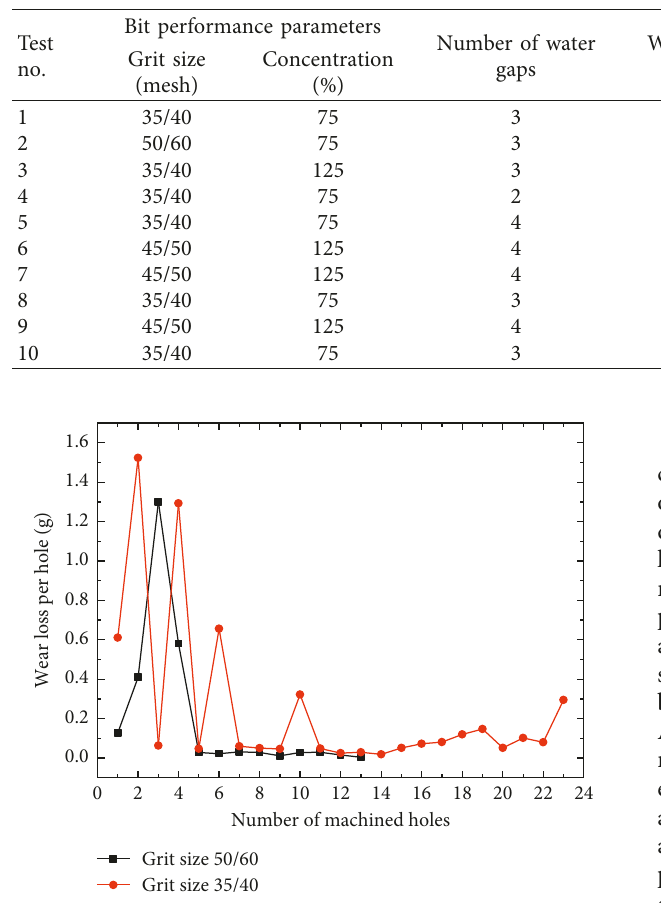
Figure 4: Wear rates of the bit under different diamond grits.